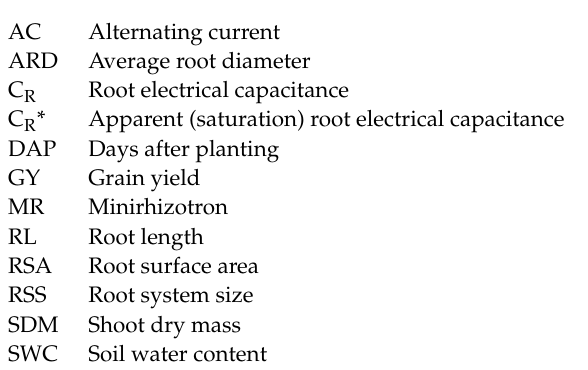
Figure S2: Changes in volumetric soil water content (SWC) with plant age (DAP: days after planting) in well-watered [(+)] and drought-stressed [(–)] treatments at different soil depths. SWC was recorded continuously at 20 and 50 cm depths using automatic data loggers, but only concurrently with root electrical capacitance measurements in the 0–12 cm layer with a handheld TDR meter. Data were averaged across the three wheat cultivars and two pea treatments. Horizontal dashed lines indicate water content at field capacity (FC; 0.02 MPa) and wilting point (WP; 1.5